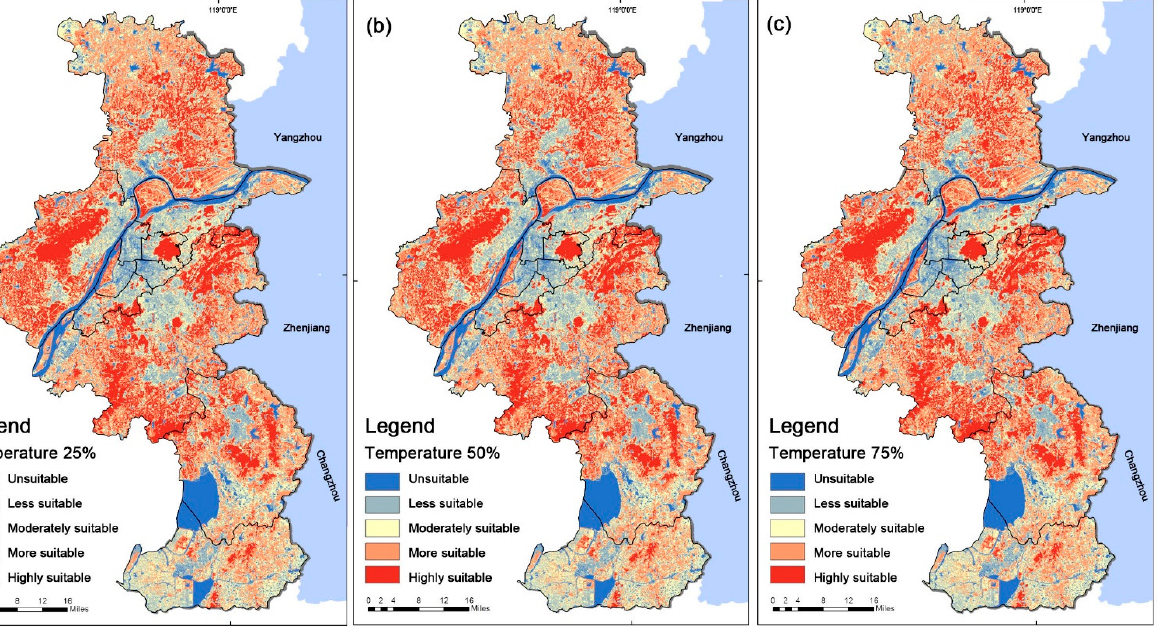
Figure 8. Results from sensitivity analysis from GIS for the criterion ‘temperature’ regarding About City Park Site Selection analysis: ( a ) Temperature 25%, ( b ) Carbon 50%, ( c ) Carbon 75%, ( d ) Tem- perature − 25%, ( e ) Temperature − 50%, ( f ) Temperature − 75%. 4. Discussion 4.1. Discussion of Research Methods An assessment system was developed in order to evaluate the land suitability of ur- ban park sites within the study area. Four key categories and thirteen factor criteria were constructed scientifically by summarizing the previous finding. Fuzzy triangular numbers